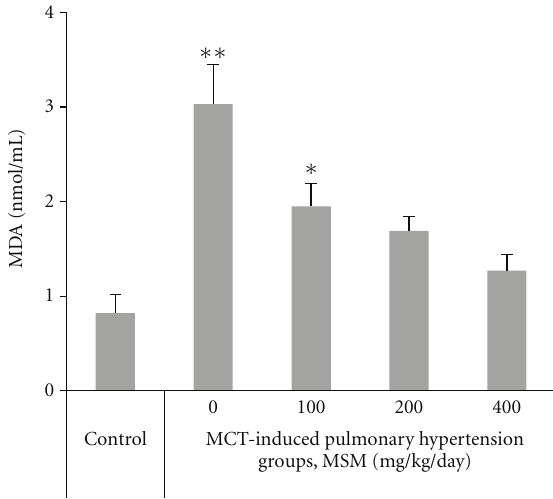
Figure 1: E ff ects of di ff erent doses (0–400mg/kg/day) of methyl- sulfonylmethane (MSM) on the reduced to oxidized glutathione (GSH/GSSG) in rats with monocrotaline- (MCT-) induced pul- monary hypertension (regression coe ffi cient r 2 = 0 . 84, P < 0 . 01). Data are means ± SE, n = 6. Significant Tukey’s post hoc di ff erences compared with controls are indicated by asterisks ( ∗∗ P < 0 . 01 and ∗ P < 0 . 05).